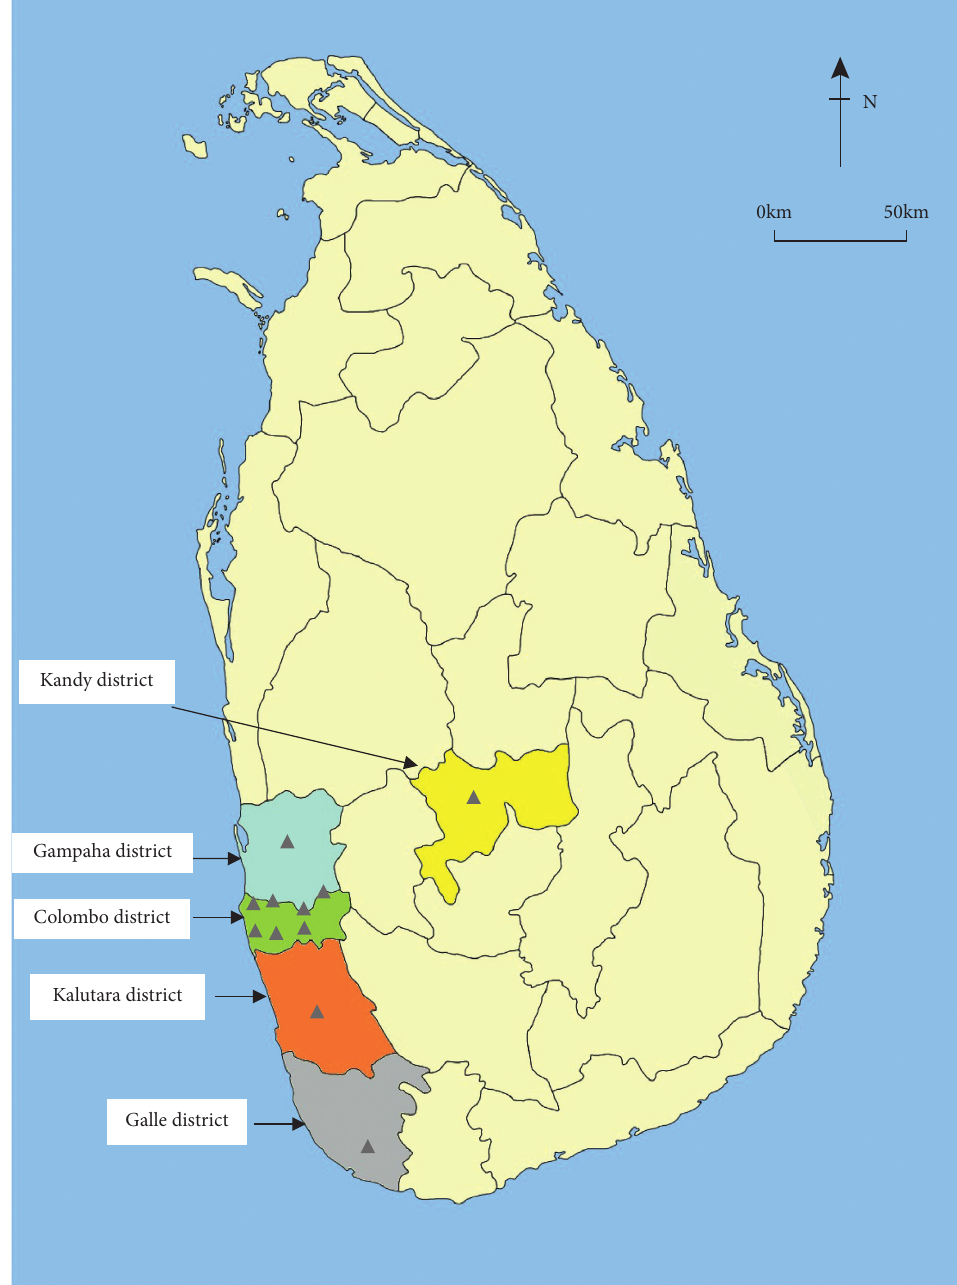
Figure 1: Locations of large-scale herbal cosmetic manufacturers in Sri